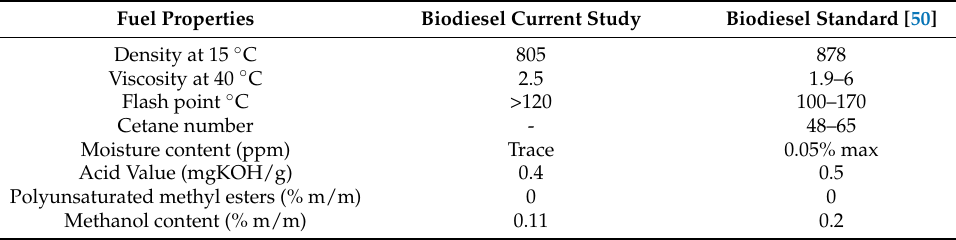
Table 4. Characterization of the biodiesel produced from waste cooking oil